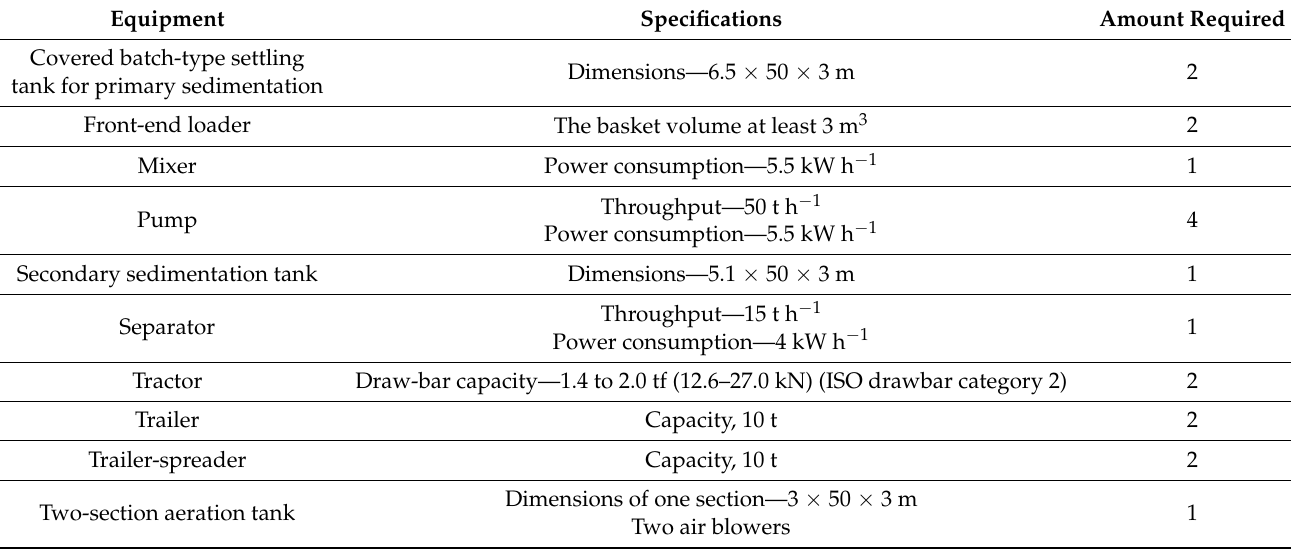
Table 3. Required equipment for the selected technology of pig manure processing.